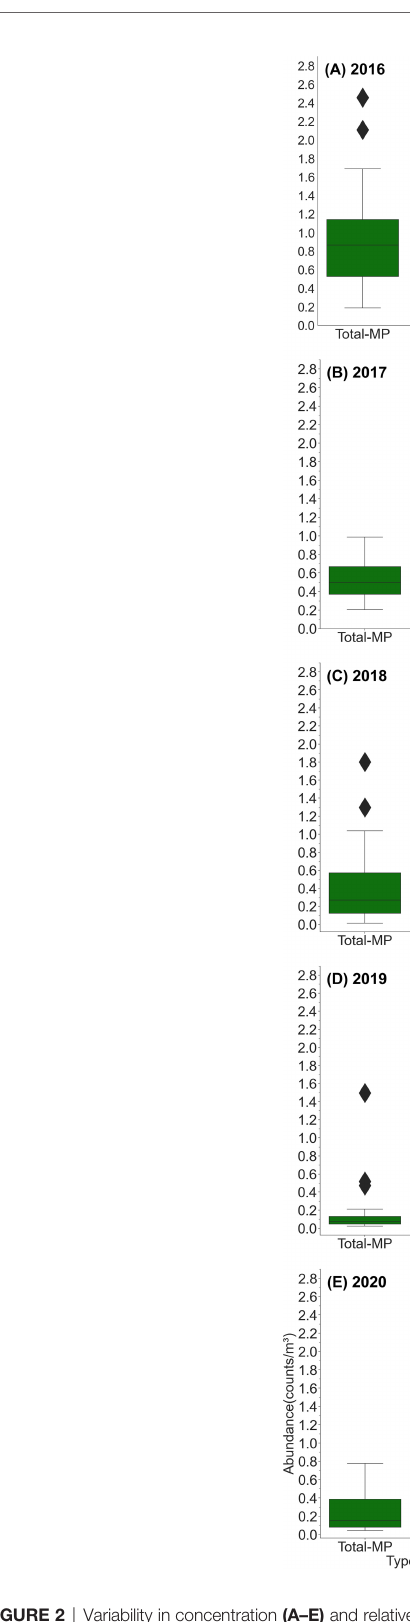
FIGURE 2 | Variability in concentration (A – E) and relative abundance (%) (F – J) of two shapes of MPs at sampling stations in the eastern Baltic